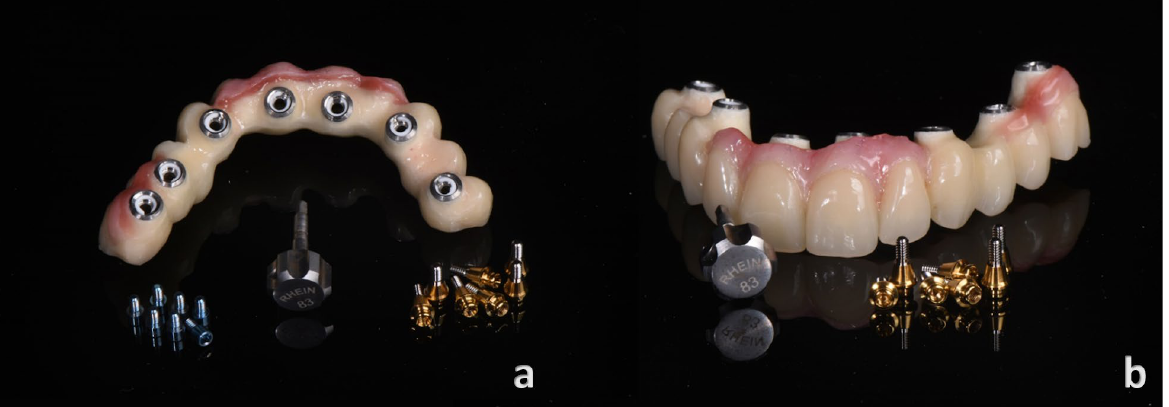
Figure 8. Milling of the framework in technopolymer material ( a ) and extragade abutments ( b ).